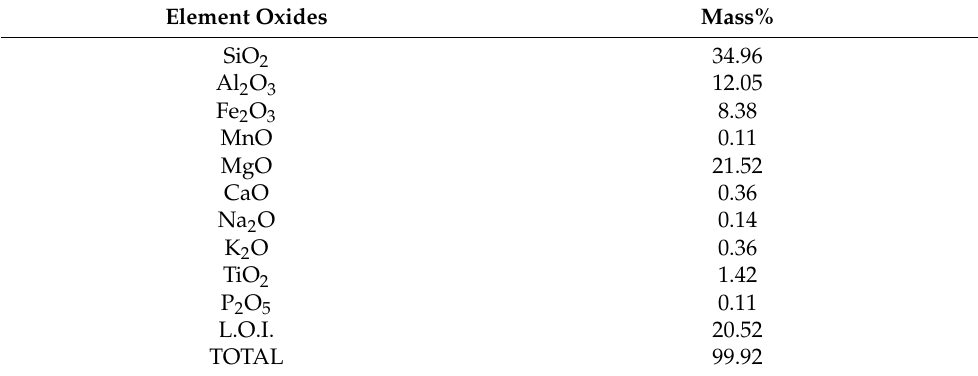
Table 1. Major elements mass percentages expressed in oxides.